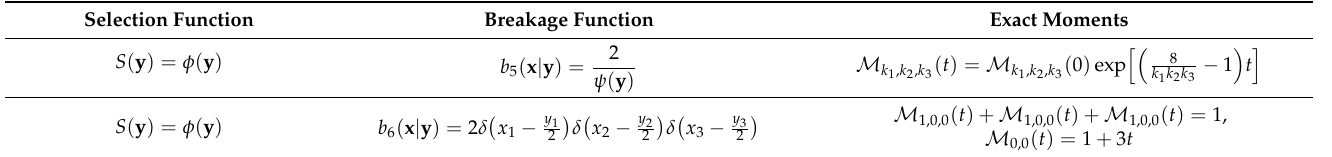
Table 12. Exact moment functions for S = φ ( y ) and breakage functions b 5 , b 6 .